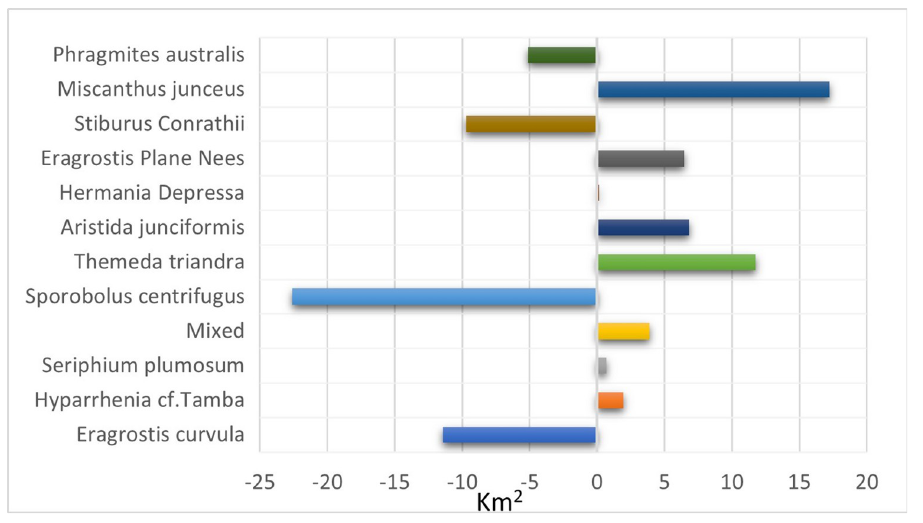
Fig 4. Vegetation transformation between 2001 and 2021.